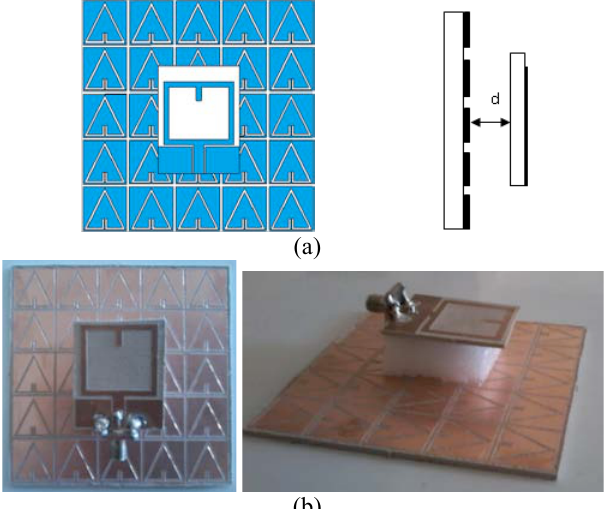
Fig .9. a) Configuration of cpw antenna with an AMC reflector, b) Photograph of the fabricated AMC with antenna on top: left (top view) and right (side view).